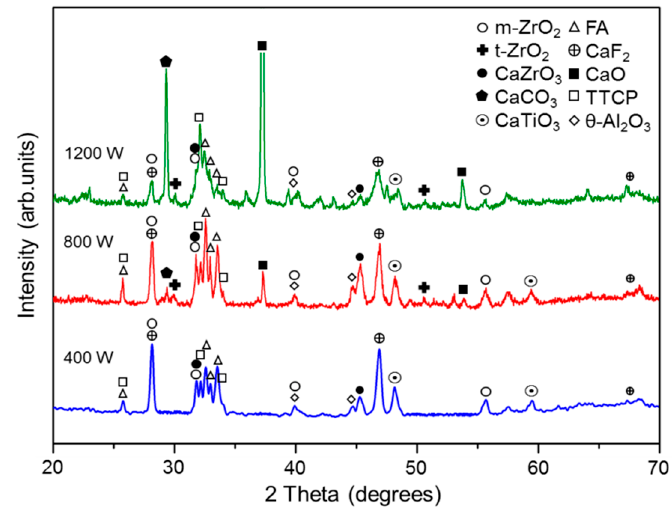
Figure 10. XRD analysis results for CLs of FA/ZrO 2 specimens prepared using different laser powers.